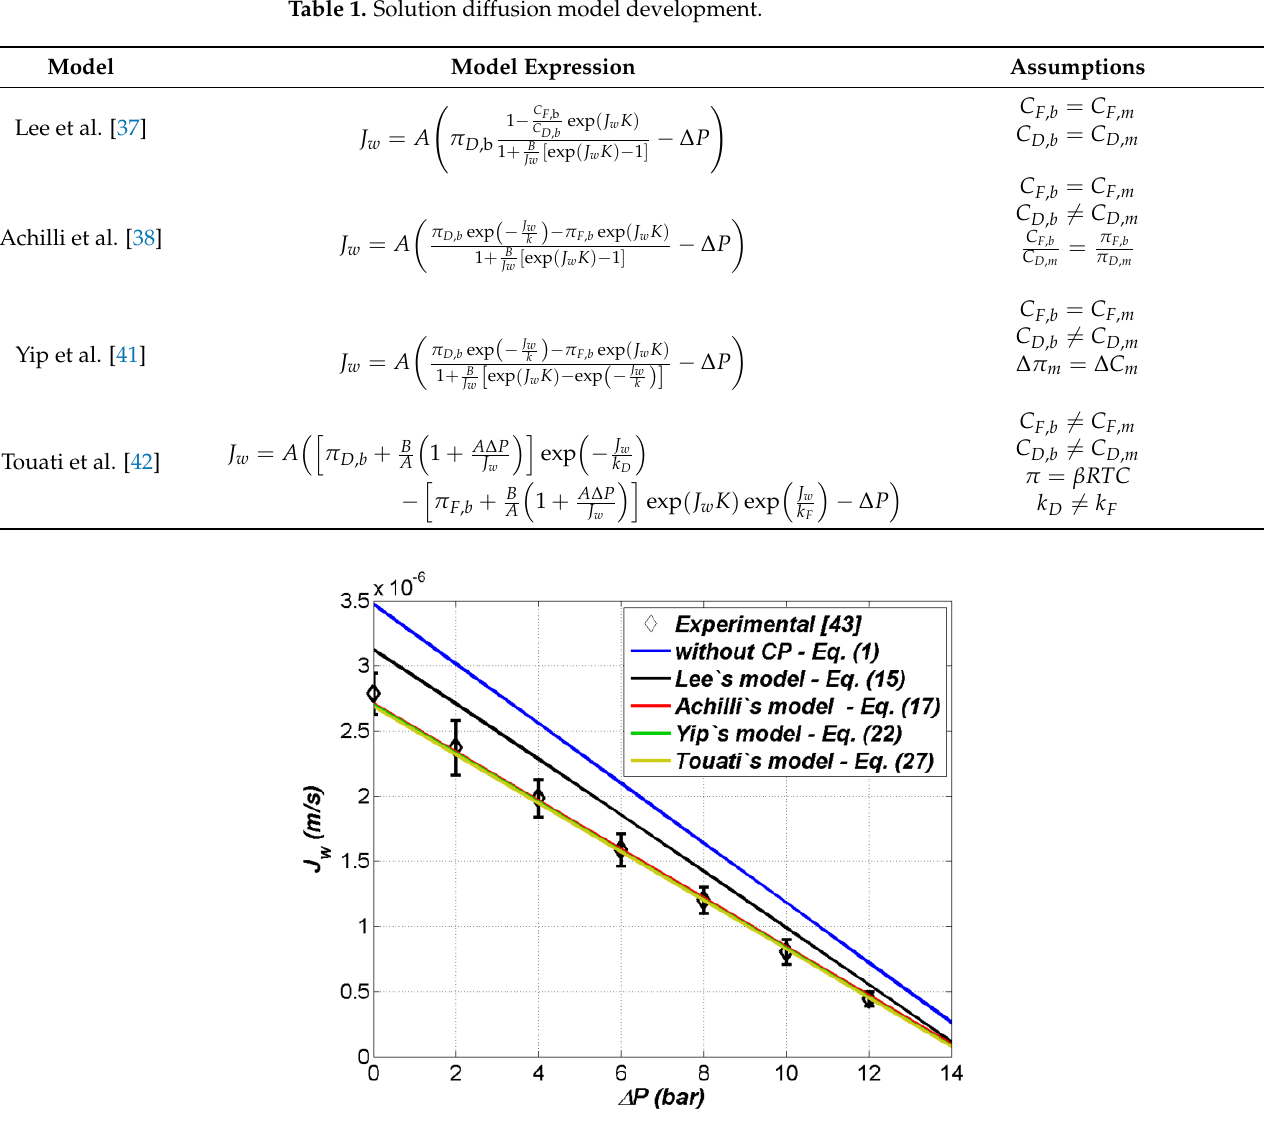
Figure 4. Comparison between the water flux generated using different modifications of the